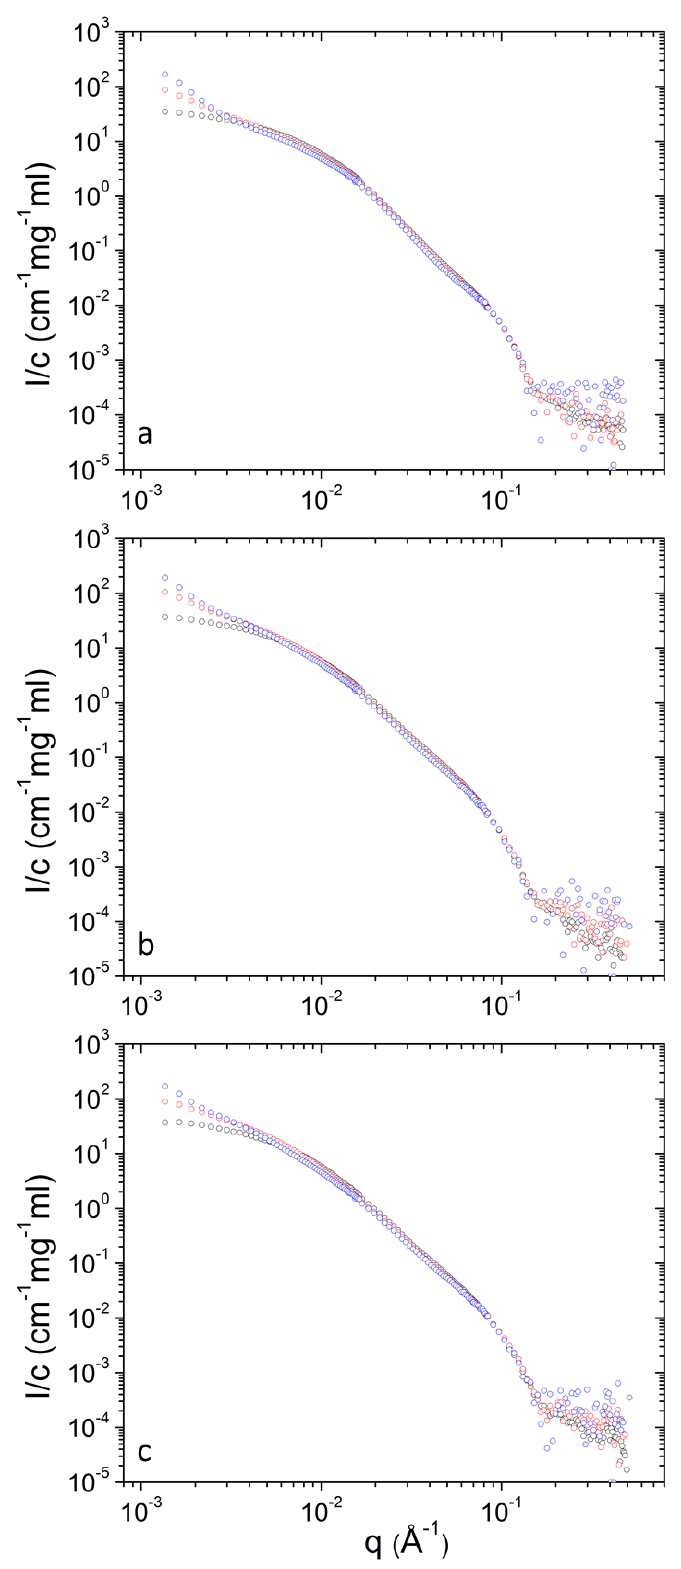
Figure 8. Concentration-normalized SANS profiles from DPPC/PEO-b-PCL2 at 3 (blue), 10 (red) and 30 (black) mg mL −1 at different temperatures i.e., ( a ) 25 °C, ( b ) 37 °C and ( c ) 45 °C.